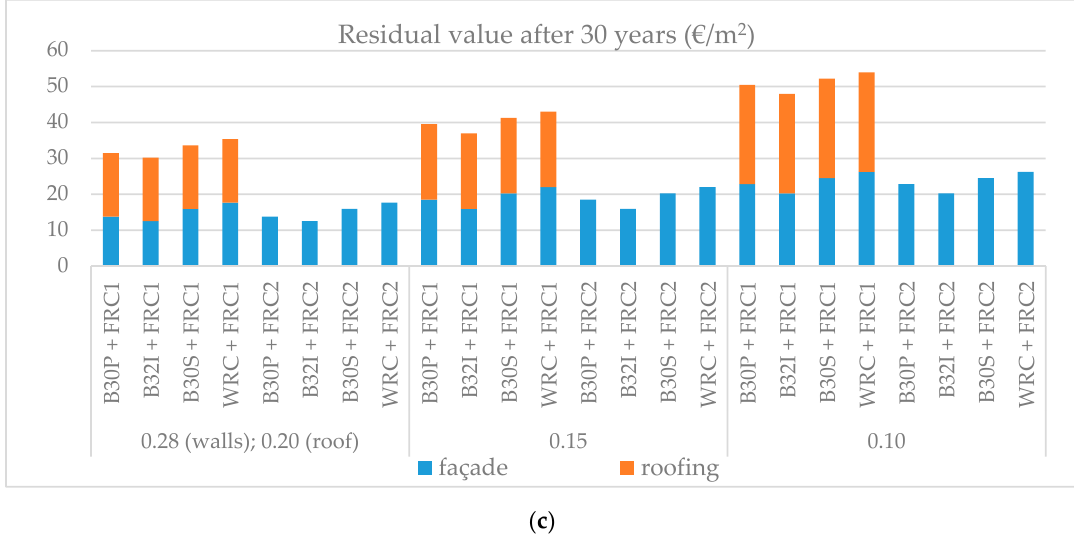
Figure 3. Comparison of life-cycle costs (LCC) for all variants: ( a ) initial investment costs; ( b ) operation and maintenance (O&M) costs; ( c ) residual value.